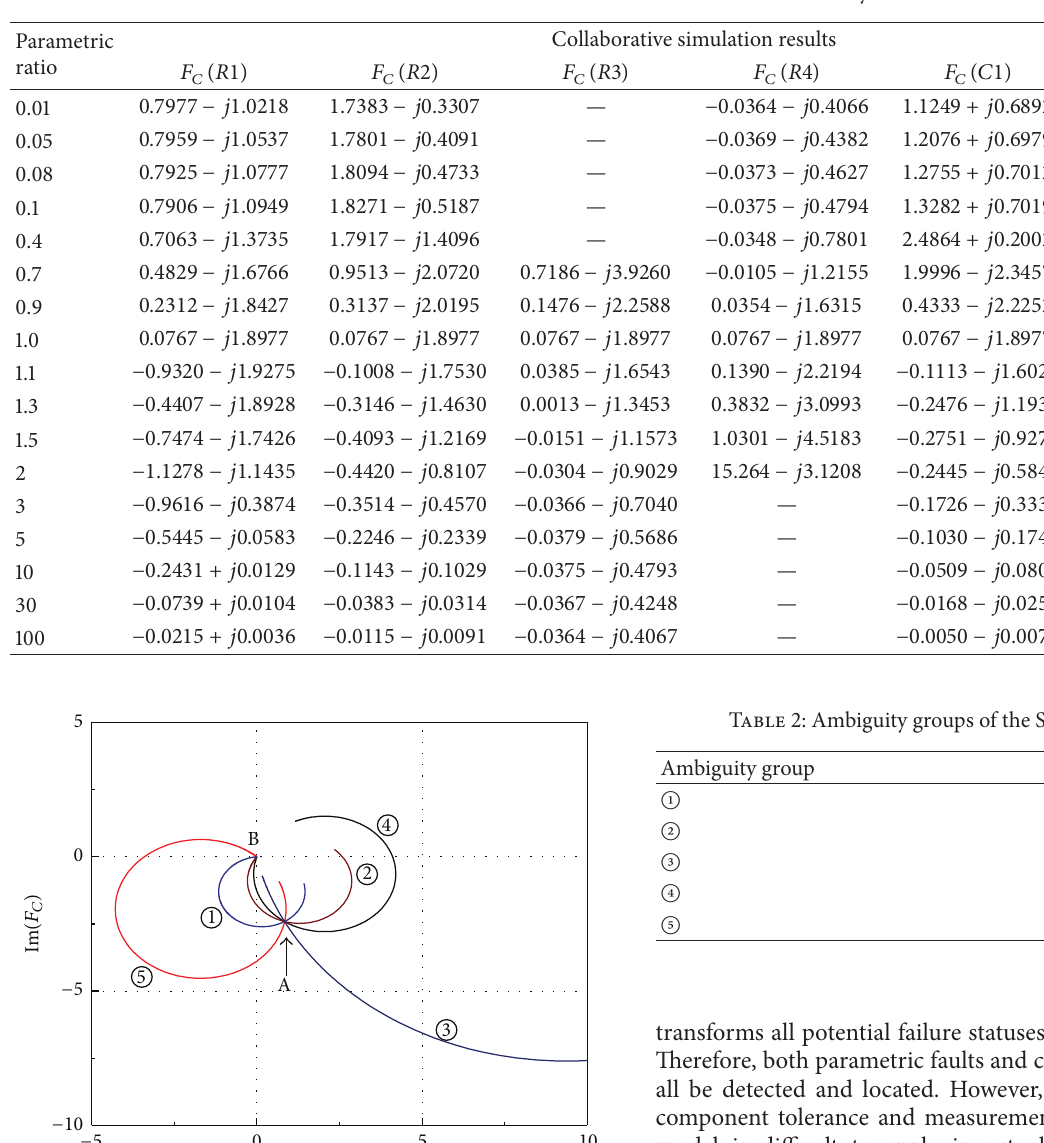
Table 1: Simulation results of 2D model for the Sallen-Key filter.